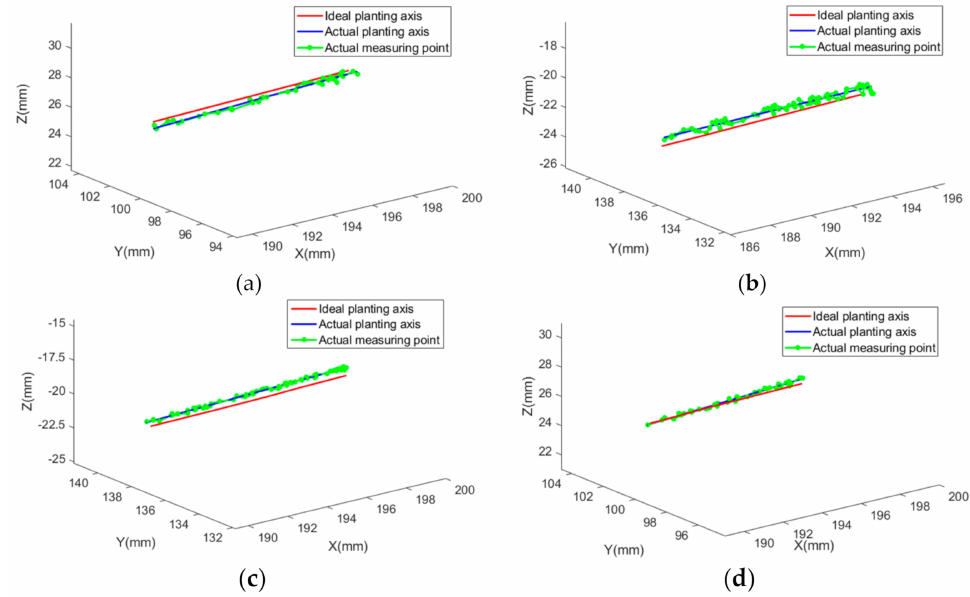
Figure 11. Deviation diagram between ideal implanting axis and actual implanting axis. ( a – d ) shows that the actual planting axis is around the ideal planting axis, and distributions of different tests are different. A deviation between the ideal planting axis and the actual planting axis is mainly composed of the calibration and registration error of the navigation system, therefore, the deviation is not fixed. Table 1. Resulting deviations for the